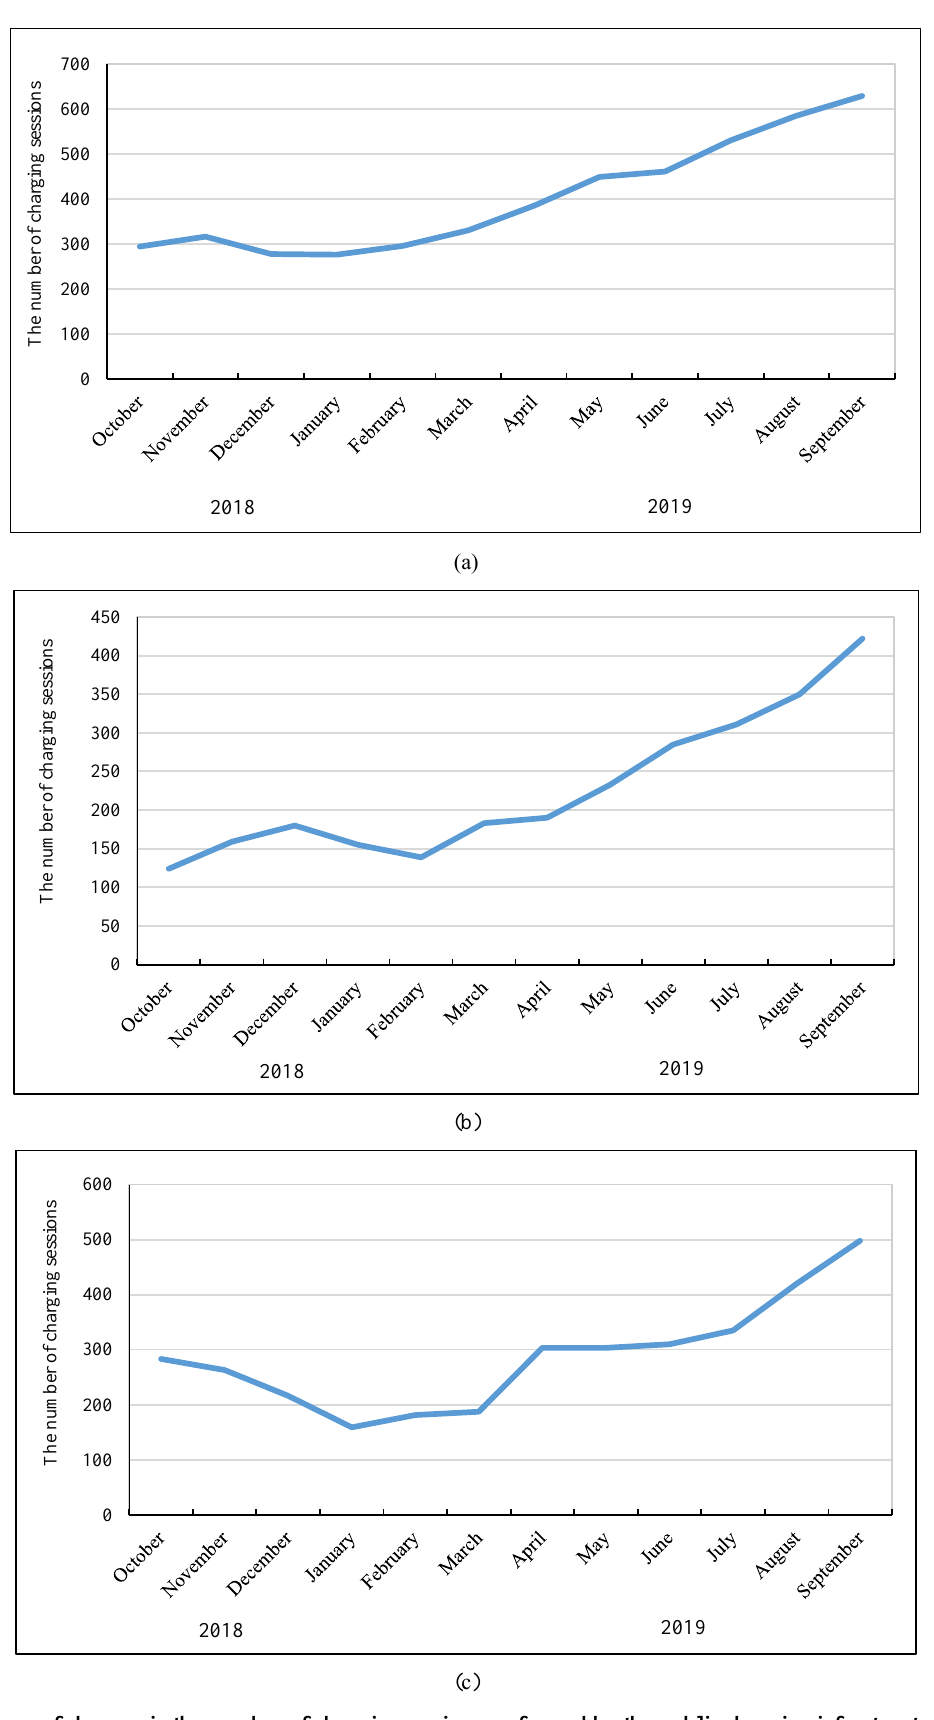
Figure 1. Curves of changes in the number of charging sessions performed by the public charging infrastructure during the year for: (a) Krasnodar; (b) Yekaterinburg; (c)